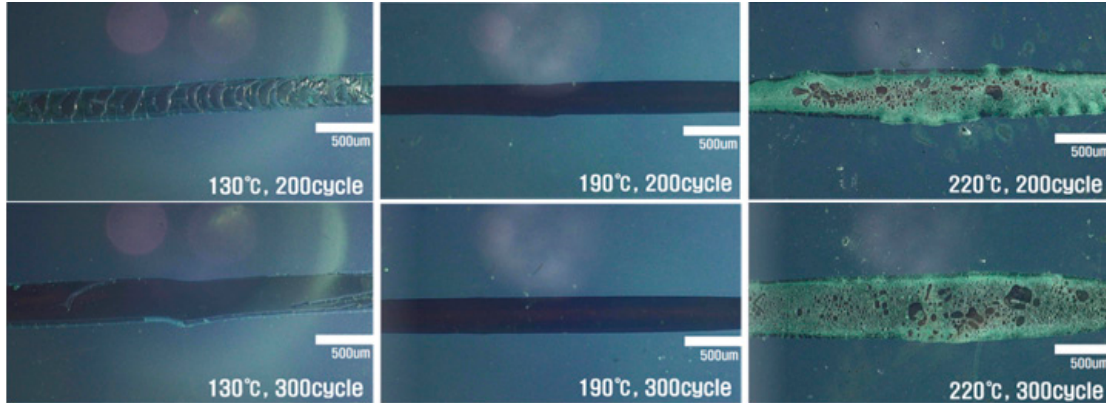
Figure 9. The microscopic photos of different stages of laser sealing as a function of sealing cycle and plate temperature. Glass fiber type of sealant is based on 1 wt% CuO-1 wt% Na 2 CO 3 codoped PSAB glass system. Appl. Sci. 2020 , 10 , x FOR PEER REVIEW